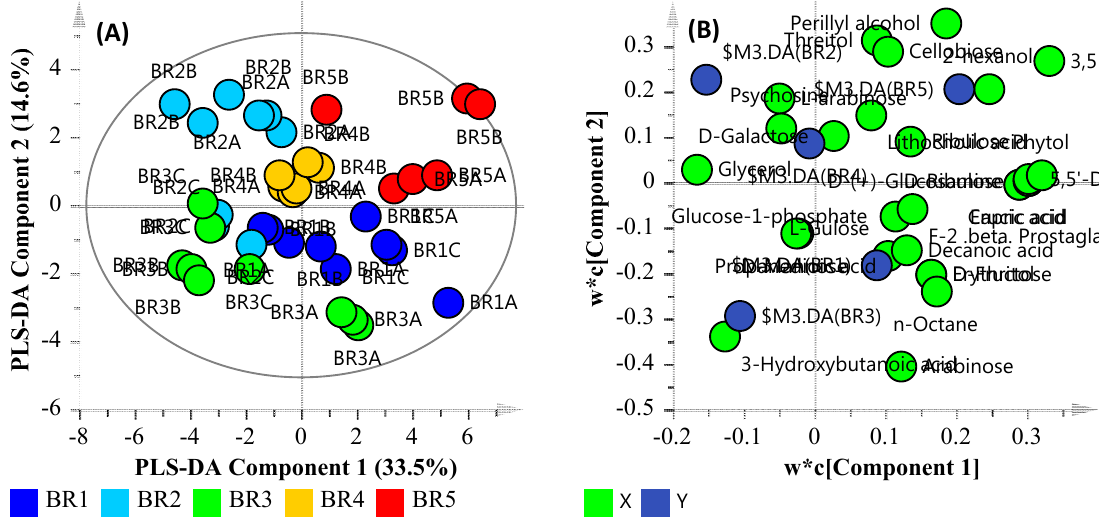
Figure 4. PLS-DA plot of the identified metabolites. ( A ) PLS-DA Score Scatter plot; ( B ) PLS-DA Loading Scatter plot.